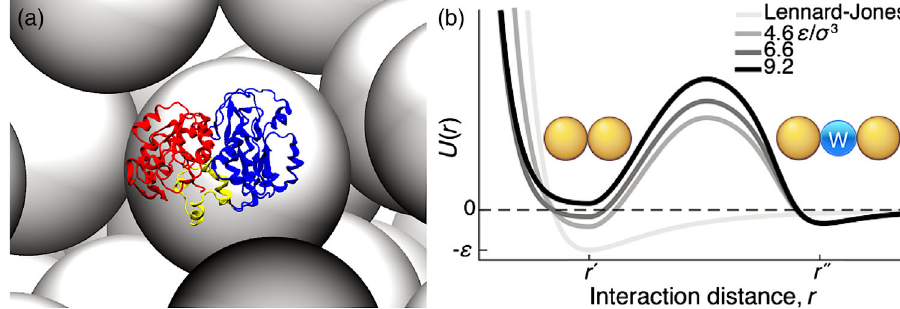
FIG. 1. PGK surrounded by crowders and the desolvation potential between residues. (a) A snapshot from the coarse-grained molecular simulation of PGK ’ s spherical compact state (SPH) surrounded by crowders (gray) at the volume fraction of 40%. The N and C domain and hinge are in red, blue, and yellow, respectively. (b) The pressure-dependent desolvation potential at σ 3 P= ϵ 0 ¼ 4 . 6 , 6.6, and 9.2 ( ϵ 0 = σ 3 ≈ 76 MPa) contains a desolvation barrier with a width ( j r 0 − r 00 j ) the size of a water molecule (blue). This barrier incorporates the entropic cost of expelling a solvent molecule between two residues (gold). The Lennard-Jones potential is plotted in light gray for